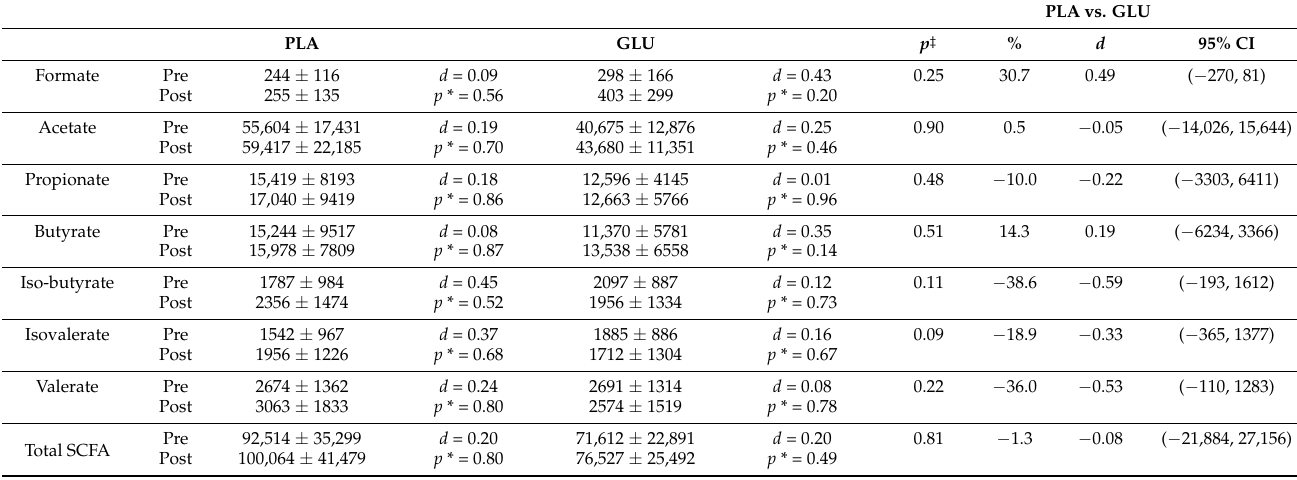
Table 3. Fecal Short-Chain Fatty Acids.